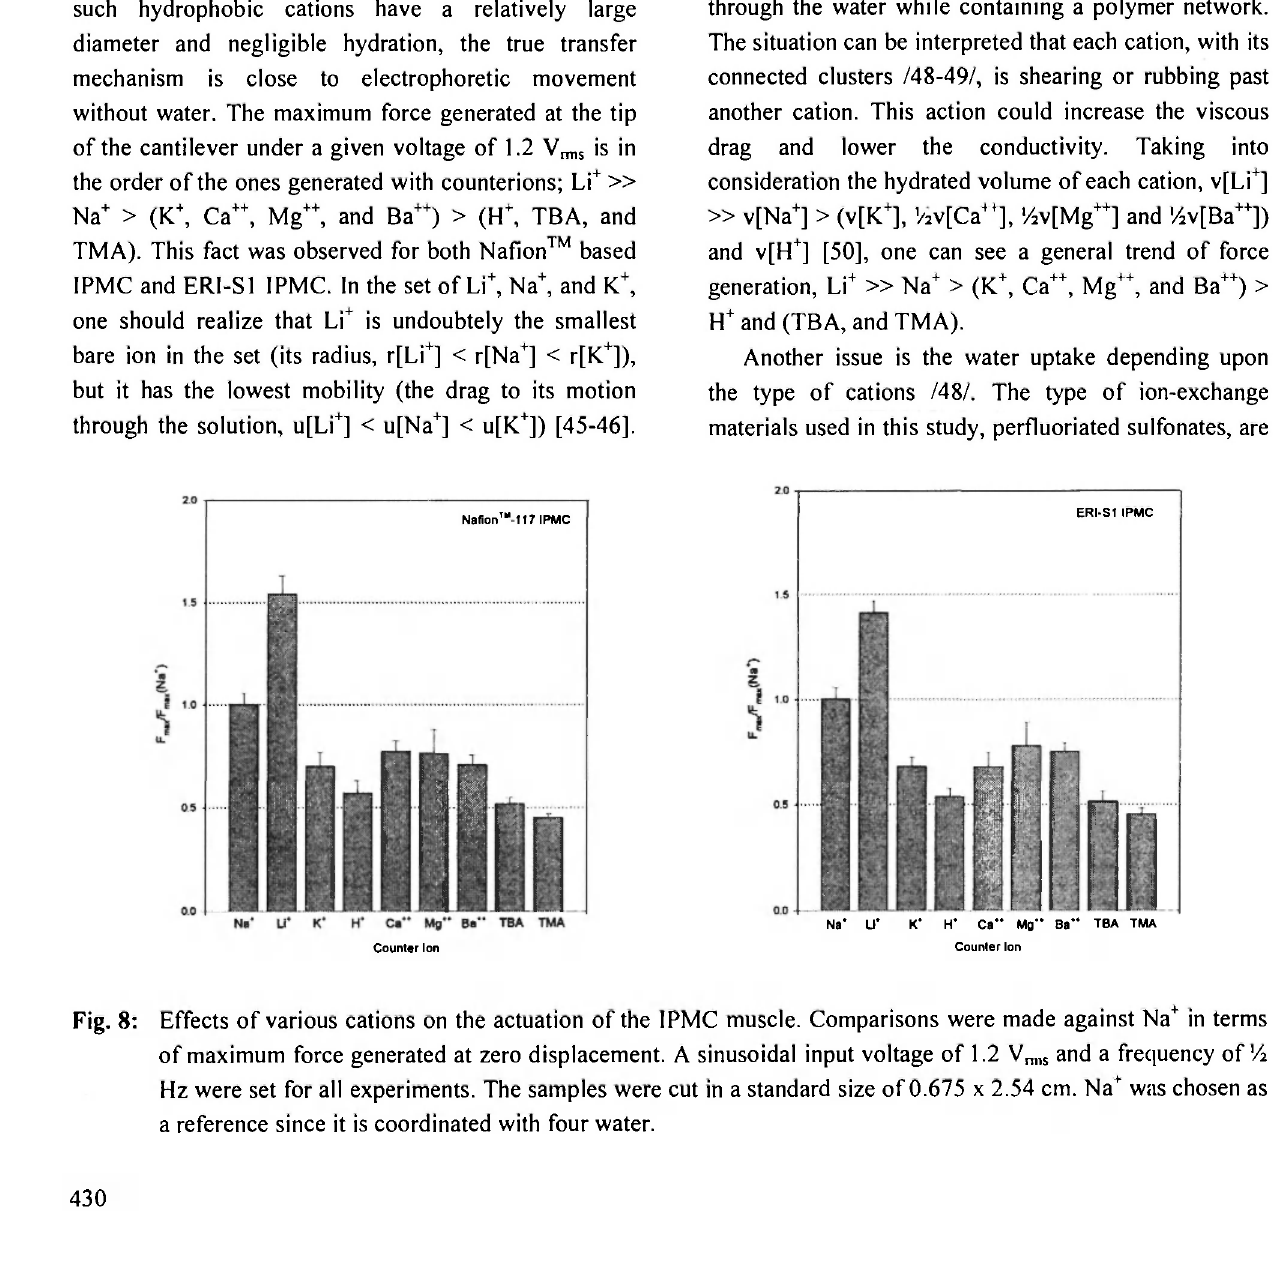
Figure 8 summarizes the test results in terms of the maximum force generated (=blocking force) by each IPMC sample (at zero displacement), containing various cations, and under a given voltage of 1.2 V mis relative to the Na + containing IPMC artificial muscle. A total 13 measurements per sample were taken, and error bars represent their corresponding standard deviations. As observed, Li + containing IPMCs (both Nafion based IPMC and ERI-S1 IPMC) are superior to the others, meaning that the hydration processes, with respect to mobile cations, plays a significant role in muscle behavior. Also, the samples with TBA and TMA show much smaller force generation capability. Knowing that